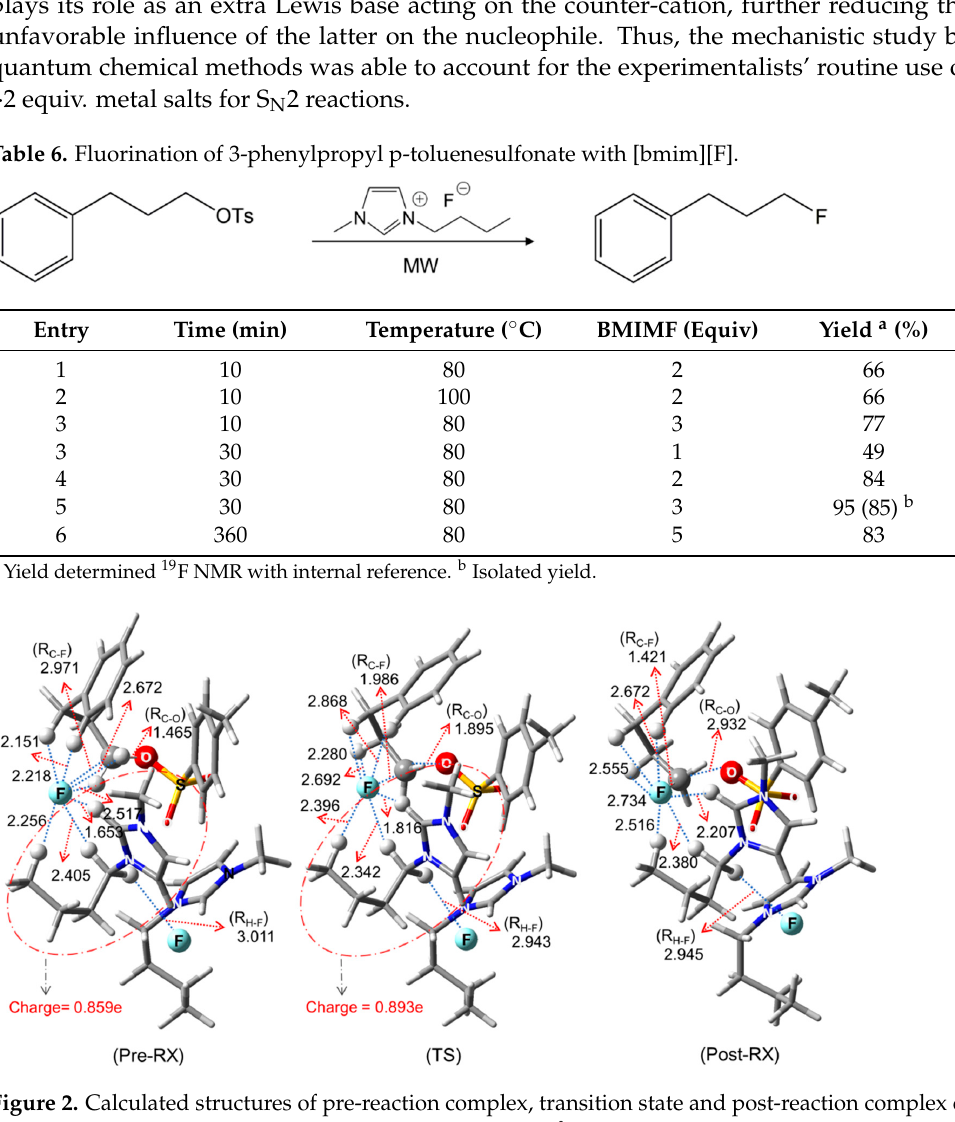
Figure 3. S N 2 fluorination of trichlorotoluene by KF in ILs.